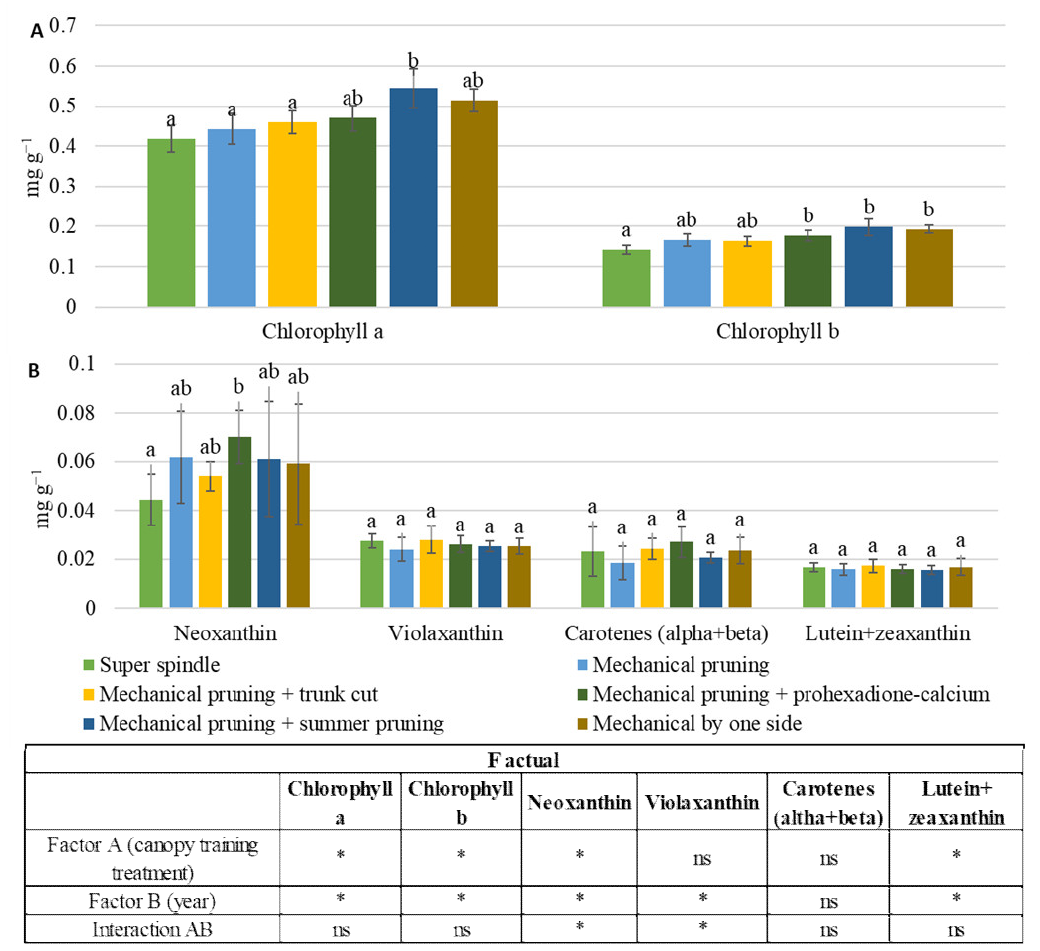
Figure 2. The effect of canopy training treatments on chlorophylls ( A ) and carotenoids ( B ) in apple cv. Rubin leaves at BBCH 87–88. The mean value of three years ( n = 3 × 3 = 9) ± standard deviation is presented. The data were processed using two-way analysis of variance (ANOVA), Tukey’s (HSD) test at p = 0.05. Different letters in blocks indicate significant differences in treatment, LSD, Fisher’s protected least: * p < 0.05; ns—not significant.